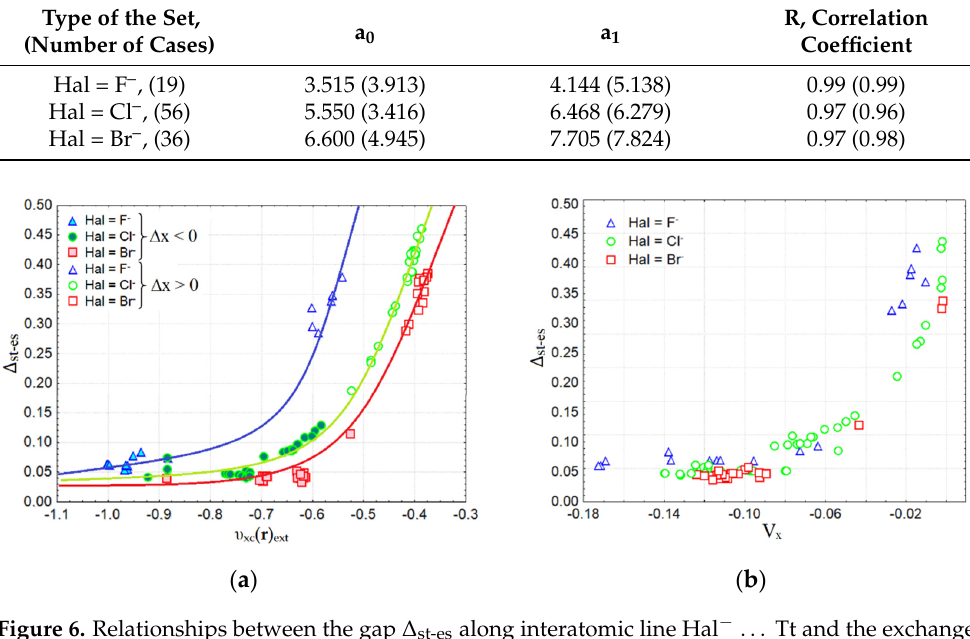
Table 1. Parameters of Equation (7) describing relationship between the gap ∆ st-es (Å) along inter- atomic line Hal – . . . Tt and the contribution of exchange-correlation potential υ xc ( r ), (a.u.) estimated on the base of extremes of potentials and at the critical points of electron density (in brackets).